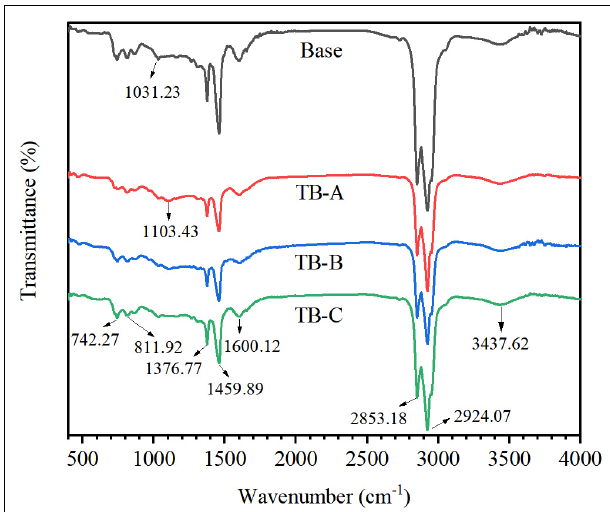
FIGURE 10 | FTIR spectrum of TB asphalt and base asphalt.